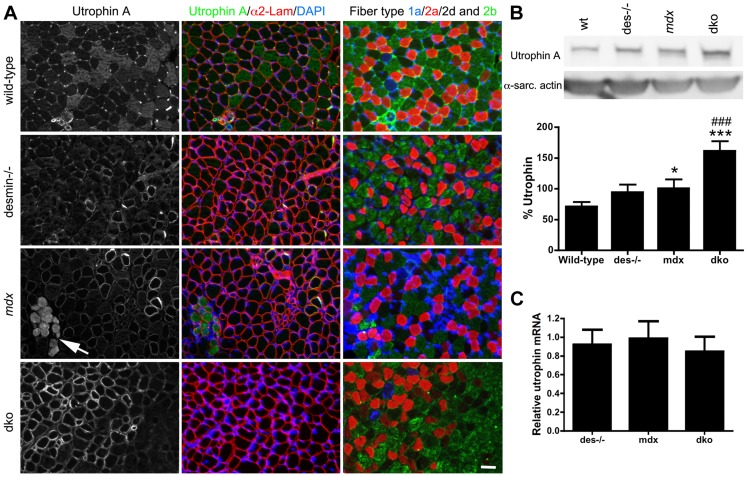
Expression and localization of utrophin in wild-type, desmin−/−, mdx4cv and dko muscles at 3 weeks of age.
A) Utrophin expression in gastrocnemius muscles compared to adjacent sections labeled for the different skeletal muscle fiber-types. Note that utrophin expression is restricted to the neuromuscular junctions and non-muscle cells in the wild-type muscles. Utrophin is also restricted to the neuromuscular junctions in most fast 2b fibers in desmin−/− muscles, but remains on the sarcolemma of the type 1a, 2a and 2d/x fiber types. Utrophin is found on the extrasynaptic sarcolemma of mdx4cv muscles, irrespective of fiber-type at 3 weeks of age. Regions where utrophin is lost from the extrasynaptic sarcolemma in mdx4cv muscles have necrotic fibers (arrows). Utrophin expression is lost from most of the fast 2b fibers in the dko by 3 weeks of age, but is retained on the sarcolemma of 1a, 2a and 2d/x fiber types. Scale bar  = 50 µm. B) Western blot analyses of utrophin A expression in whole gastrocnemius muscle lysates from (n = 4), desmin−/− (n = 4), mdx4cv (n = 8) and dko (n = 8) mice. Quantitation of utrophin expression in whole muscle lysates is shown below the immunoblots. C) We found no change in utrophin mRNA when comparing whole gastrocnemius muscle lysates, when utrophin mRNA was normalized to the housekeeping gene Ywhaz. N = 4. *P<0.05, P<0.001 compared to wild-type. ###
P<0.001 compared to mdx4cv.